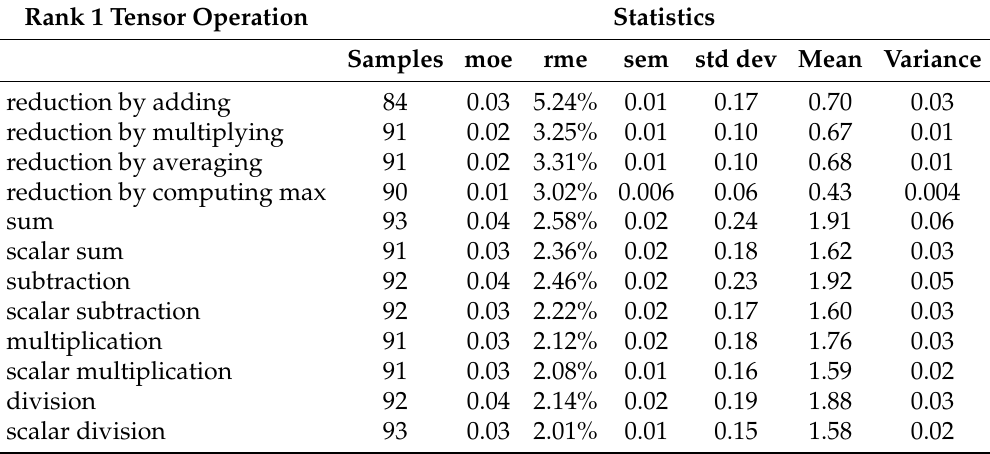
Table 18. Raspberry Pi IV benchmark statistics for rank 1 tensor operations with k = 64 (times in ms).